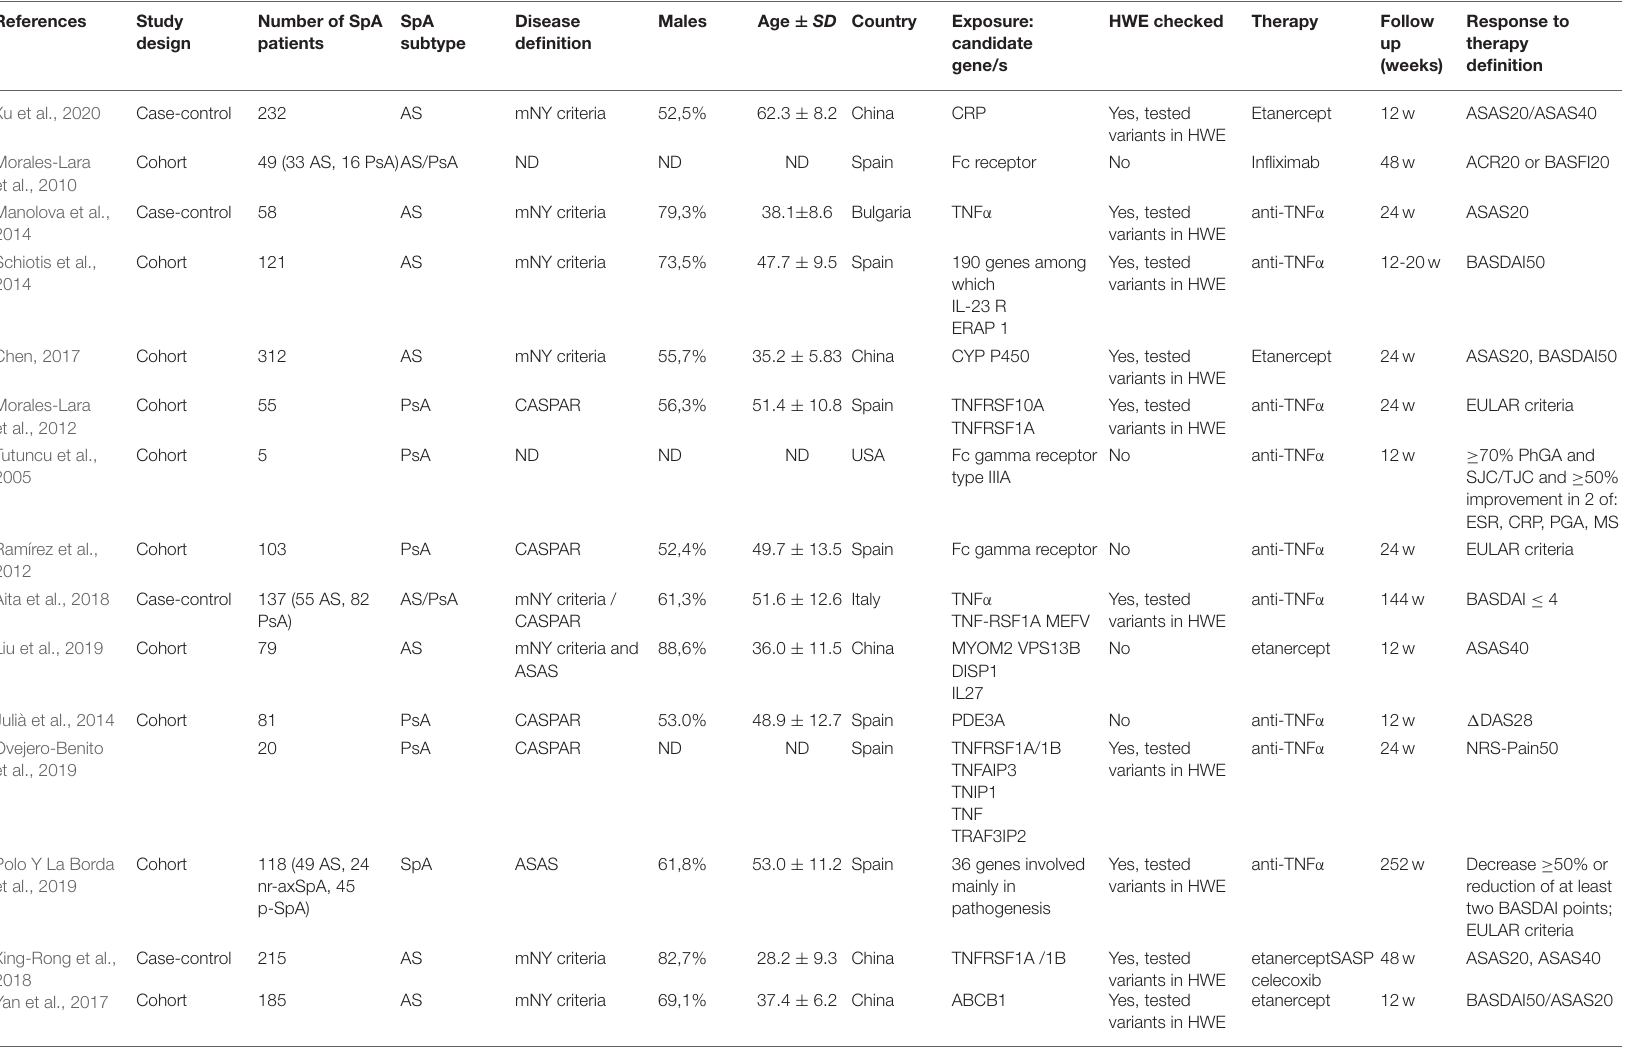
TABLE 1 | Characteristics of the studies satisfying inclusion and exclusion criteria for the SLR, with particular reference to study design and characteristics of population, exposure,